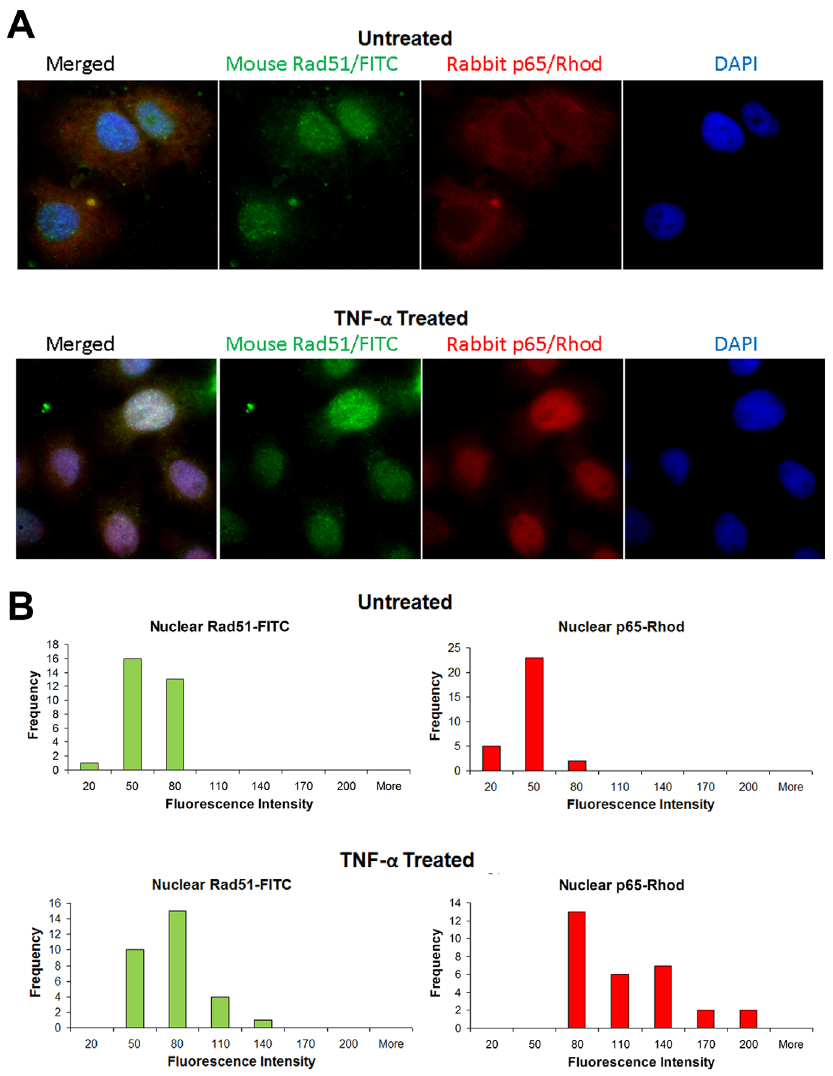
Figure 8. Effect of TNF- a on subcellular localization of NF- k B p65 and Rad51: immunocytochemistry. A. TC620 cells were either untreated or treated with 10 ng/ml TNF- a for 20 min and subject to ICC with antibodies to p65 and Rad51, washed, mounted with DAPI-containing mounting medium and viewed by fluorescence microscopy as described in Materials and Methods. Note, these cells were not transfected so the fluorescence is due to endogenous p65 and Rad51. B. Quantification of immunocytochemistry images: Images of labeled cells were analyzed using Adobe Photoshop CS. Nuclear areas of the labeled cells were manually outlined using the lasso selection tool based on DAPI labeling and the average fluorescence intensity levels for the red and green channels were recorded from 30 nuclei for each condition. Next, the fluorescence intensity levels data were converted into histograms using the Analysis Toolpack add-in of Microsoft Excel.